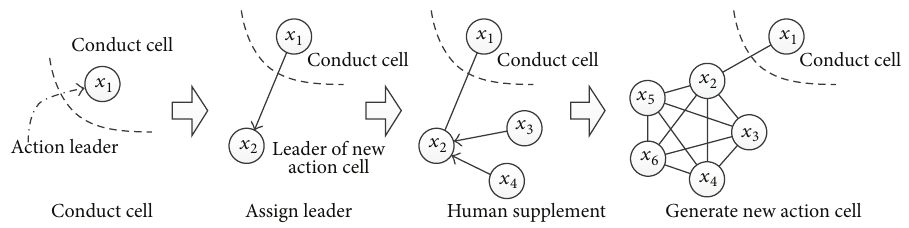
Figure 7: The growth mechanism of terrorist